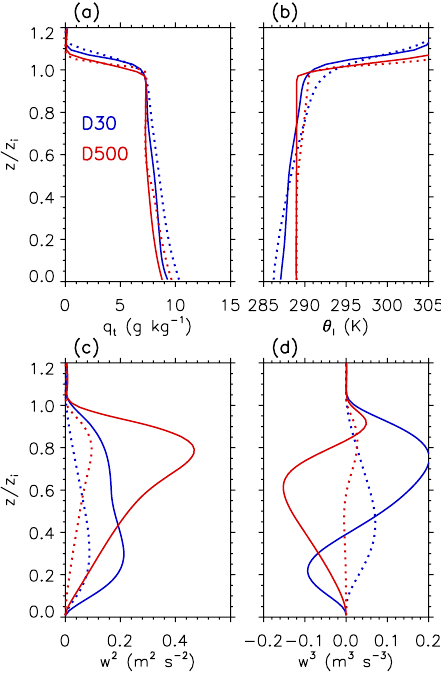
Fig. 4. Vertical profiles of (a) total water mixing ratio q t , (b) liq- uid water potential temperature θ l , (c) variance of vertical velocity w 0 2 , and (d) third moment of vertical velocity w 0 3 . Profiles are domain-averages at night between t =3 and 9h (solid) and in the day between t =9 and 15h (dotted). Note that vertical axis is nor- malized by the corresponding mean inversion base height, which is larger in D500 than in